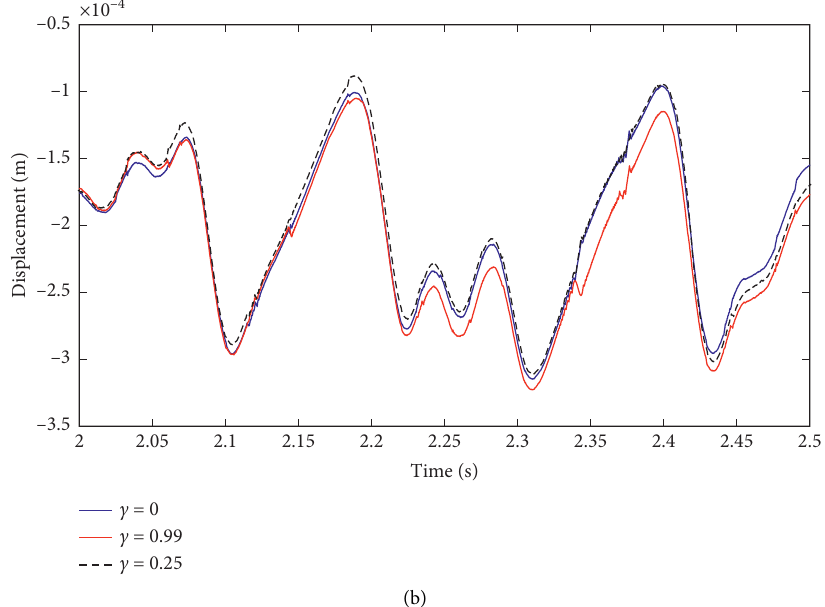
Figure 14: Controlled system behavior for different values of c and α � β � 3. (a), (b). Detailed view of Figure 13(a).